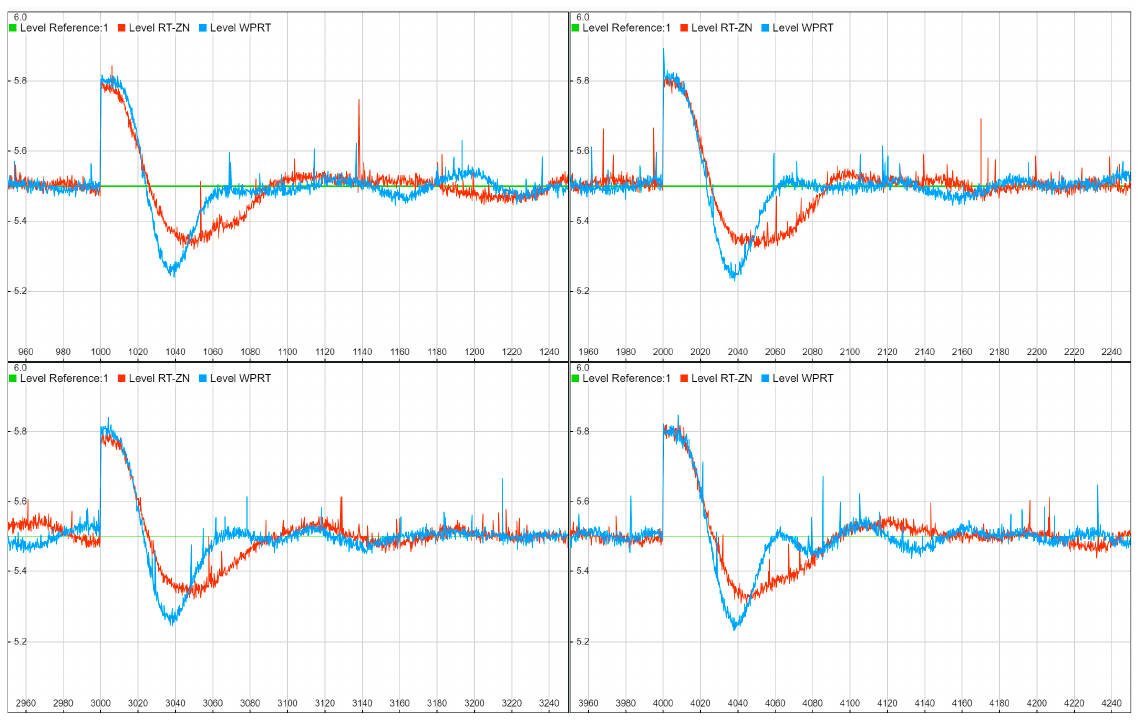
Figure 12. Process output disturbance test: At the process’s output, the level measurement was artificially increased by 0.3 m. Water-level setpoint (green), RT-ZN tuning (red), proposed WPRT method (blue).